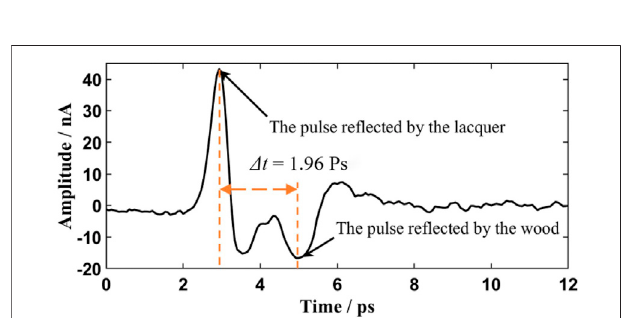
FIGURE 7 | A time-domain spectrum of one point.